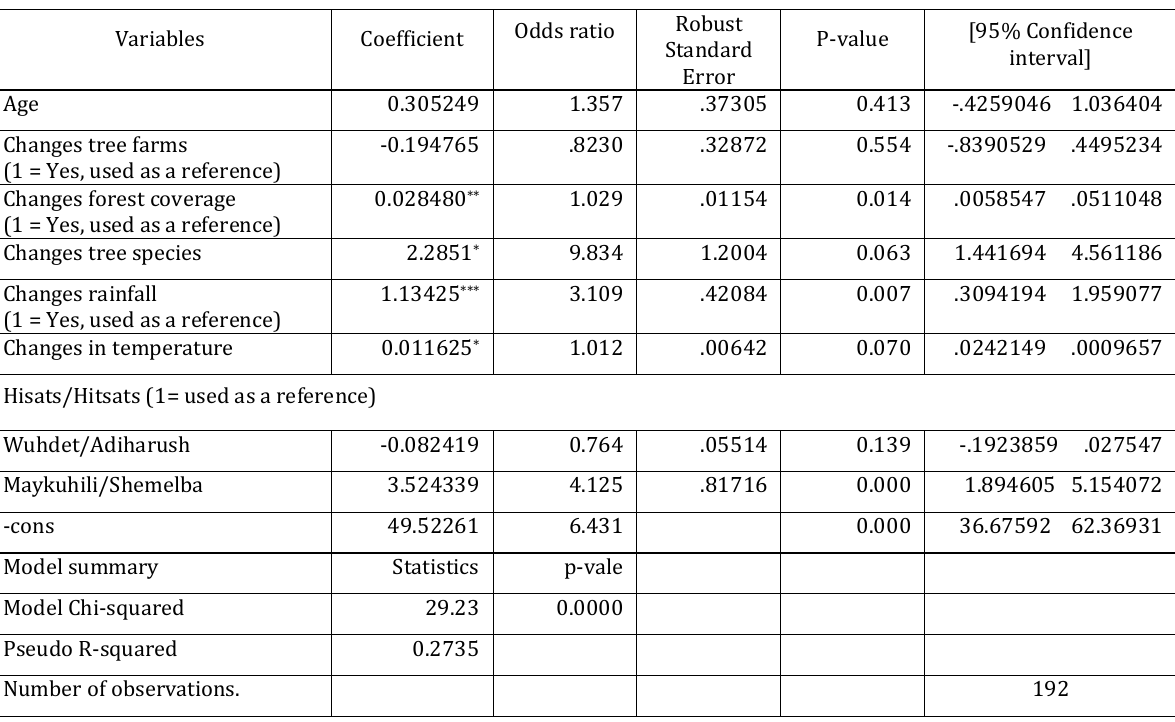
Table 3. Socio-environmental impact of refugee populations on hosting communities: Estimates of a logistic